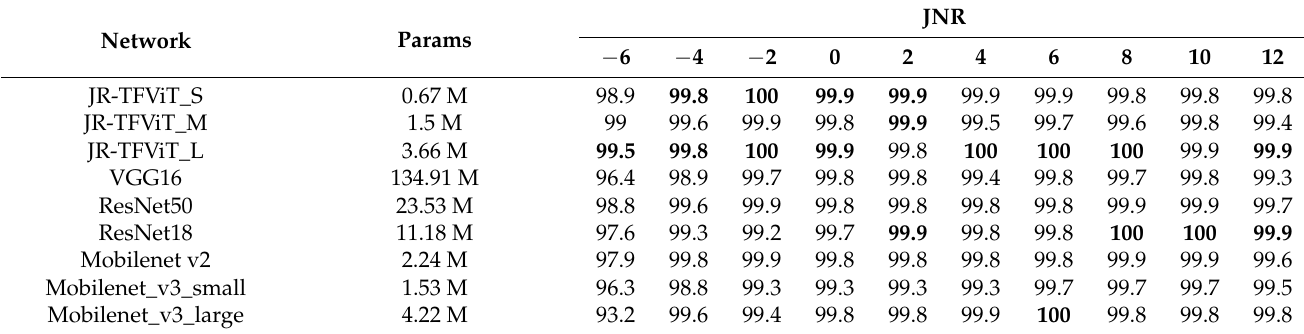
Table 4. The OA of the nine networks in different JNR conditions. The best accuracy is highlighted in bold.